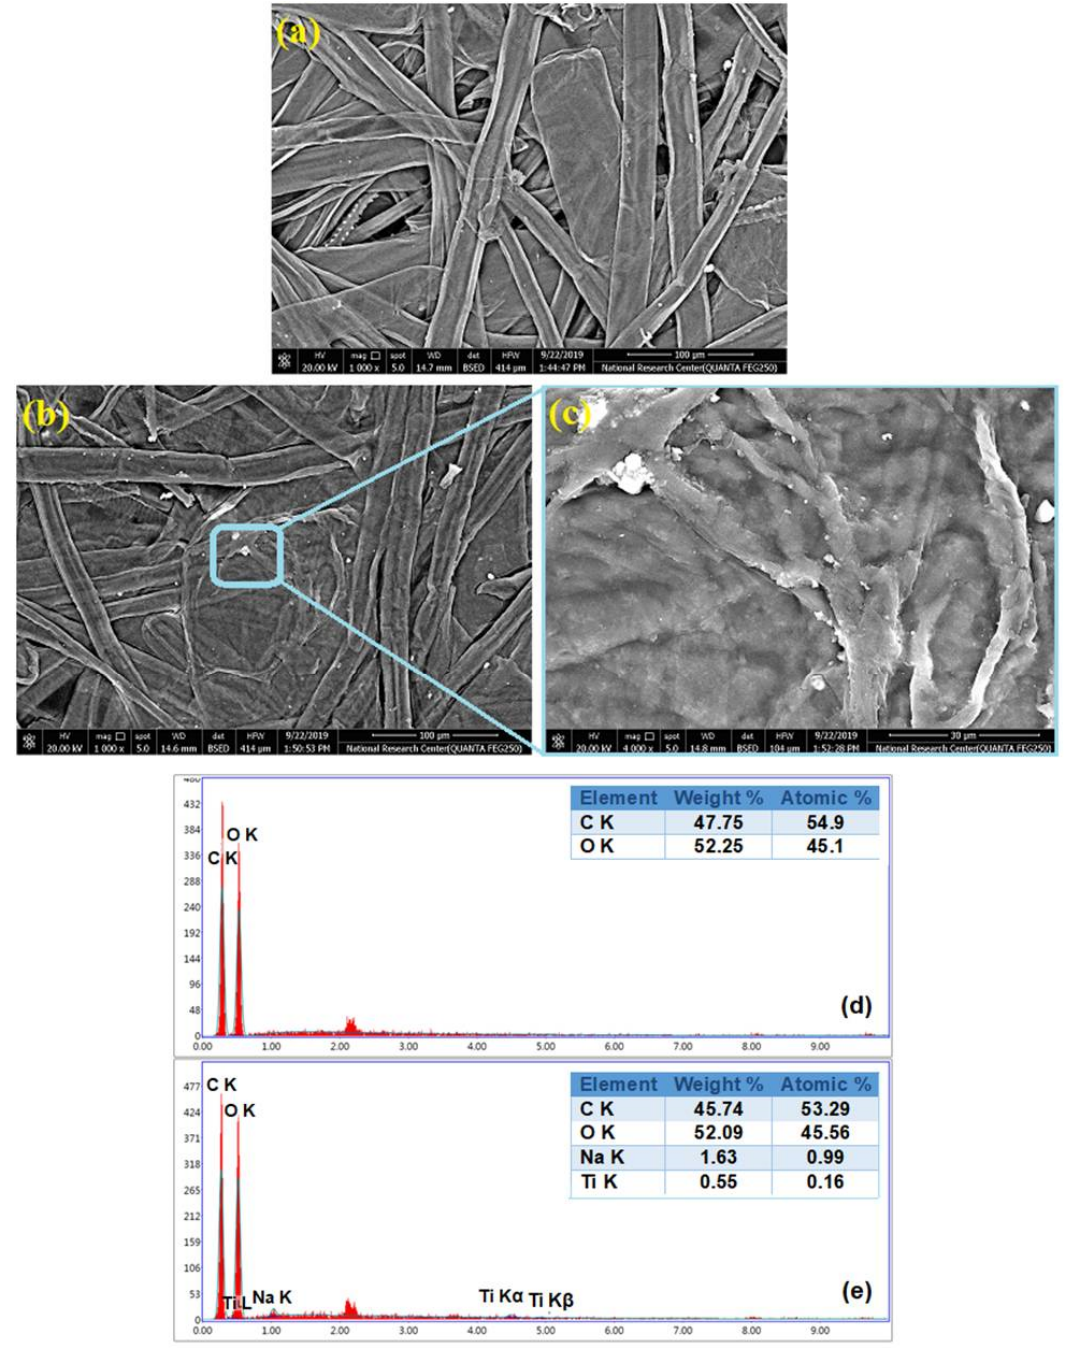
Figure 7. SEM images of ( a ) blank paper sheet, and ( b , c ) 1.0% TiO 2 -modified paper sheet, Energy-dispersive X-ray spectroscopy (EDAX) analysis of ( d ) blank paper sheet, and ( e ) 1.0% TiO 2 -modified paper